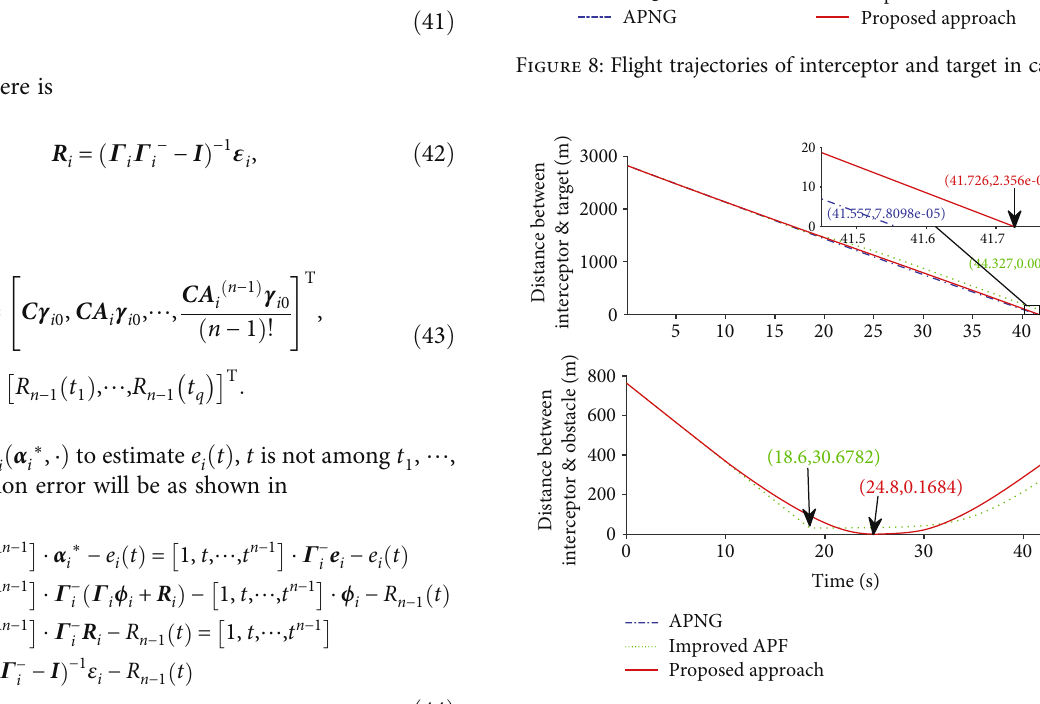
Figure 9: Changes of two distances in case